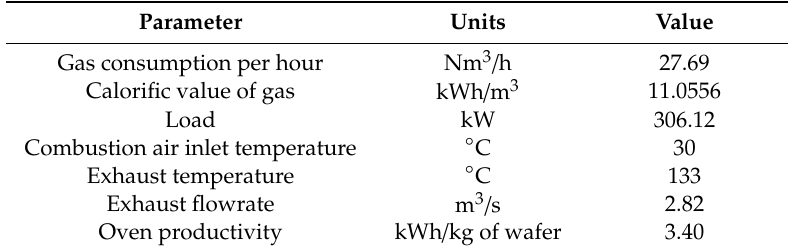
Table 6. Baseline key performance indicators of pilot-scale baking oven.